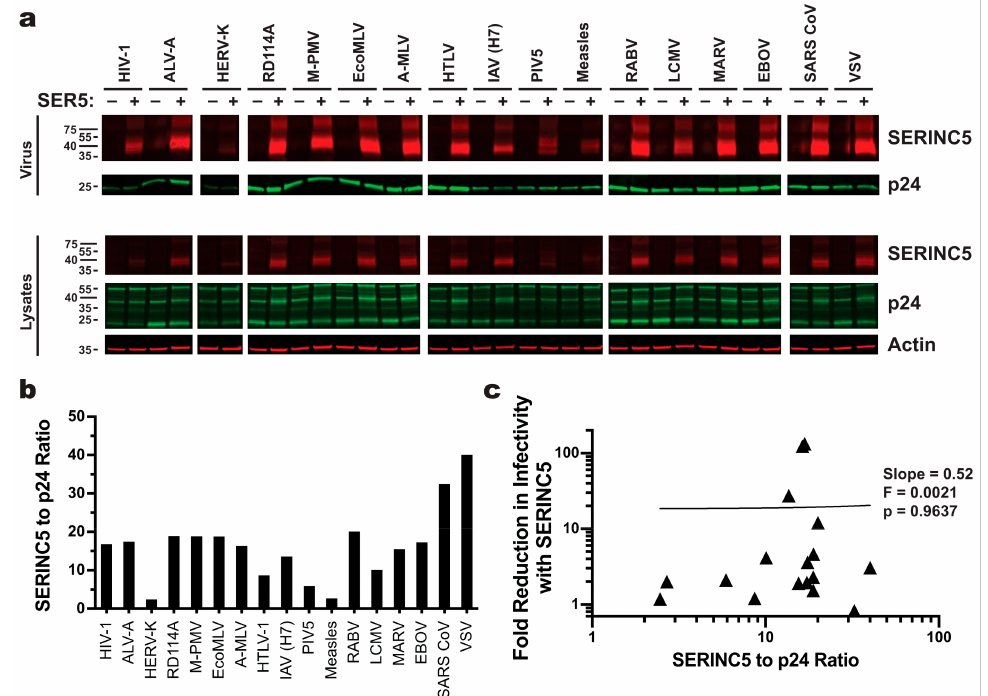
Figure 4. SERINC5 incorporation efficiency does not correlate with its antiviral activity. ( a ) [Top] Western blots of enriched HIV-1 pseudovirions produced in the presence or absence of C-terminally HA-tagged SERINC5. Blots were probed with mouse monoclonal anti-HA and human anti-p24 monoclonal 241-D. [Bottom] Western blots of lysates from the HEK293 cells that were used to produce the pseudovirions in the top panel. Blots were probed with mouse anti-actin in addition to anti-HA and anti-p24. ( b ) Quantitation of blots shown in panel A. The signal for SERINC5 incorporated into cell-free HIV-1 pseudovirions was normalized to p24. ( c ) Linear regression analysis of normalized amounts of SERINC5 incorporated into pseudovirions ( b ) versus the magnitude SERINC5 inhibition ( a